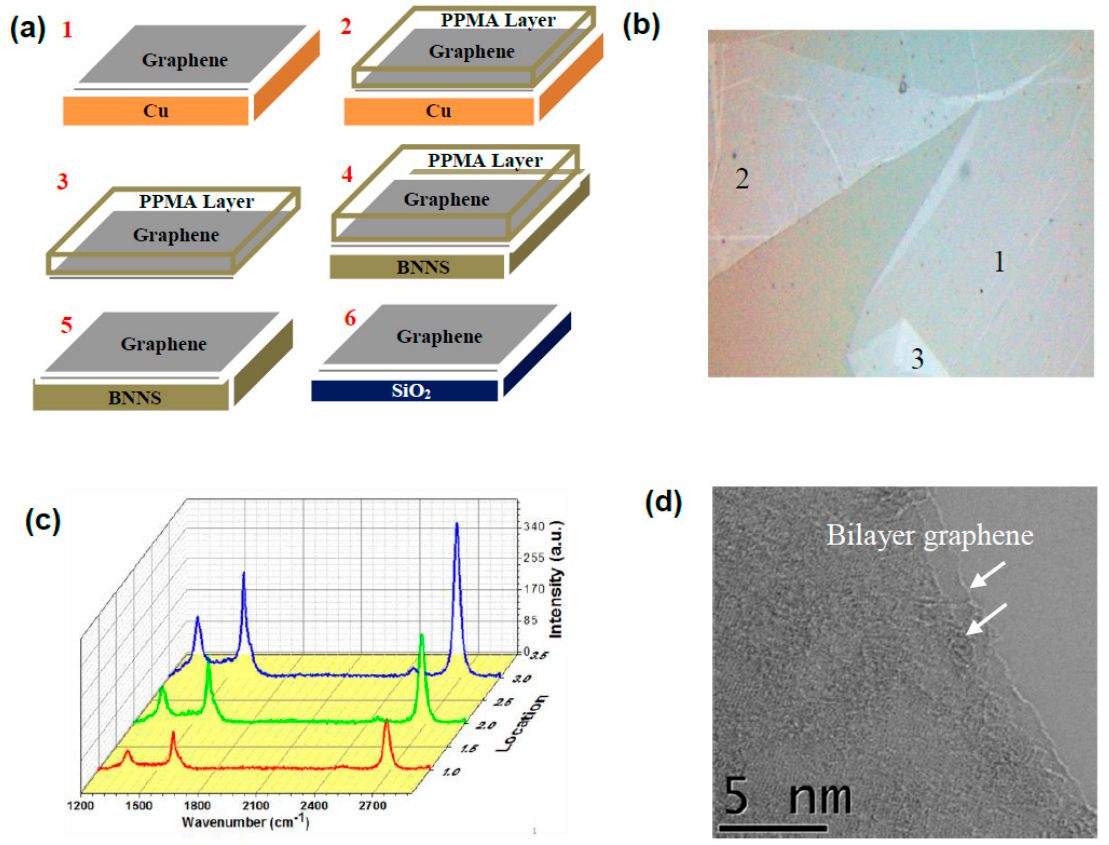
Figure 2. ( a ) Schematic diagram illustrating graphene transfer procedure from copper substrate to BNNS and SiO 2 supports using PMMA process. ( b ) Optical image of the graphene sheet transferred on quartz substrate under 600 nm illumination collected by Raman system. ( c ) Raman spectra collected from different locations marked in ( b ). ( d ) HRTEM image showing graphene bilayer with observed displacement between individual layers.